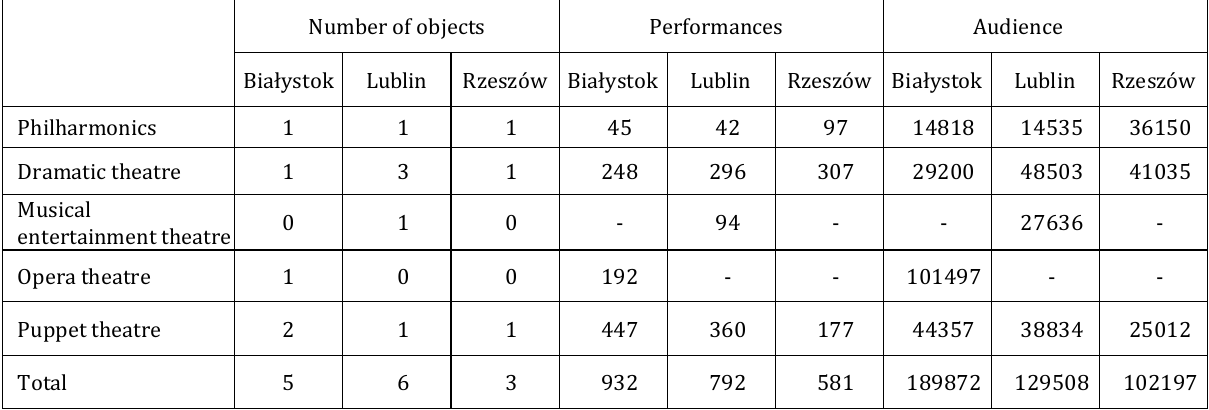
Table 4. Philharmonics and theatres in Białystok, Lublin, and Rzeszów (2014) (author’s own elaboration based on the Local Data Bank of the Central Statistical Office) Number of objects